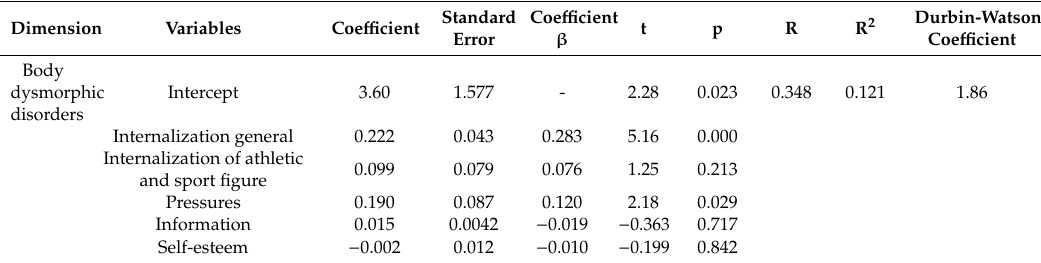
Table 3. Multiple linear regression with Body Dysmorphic Disorders (total score) as dependent variable, and Sociocultural Attitudes towards Appearance, and self-esteem as